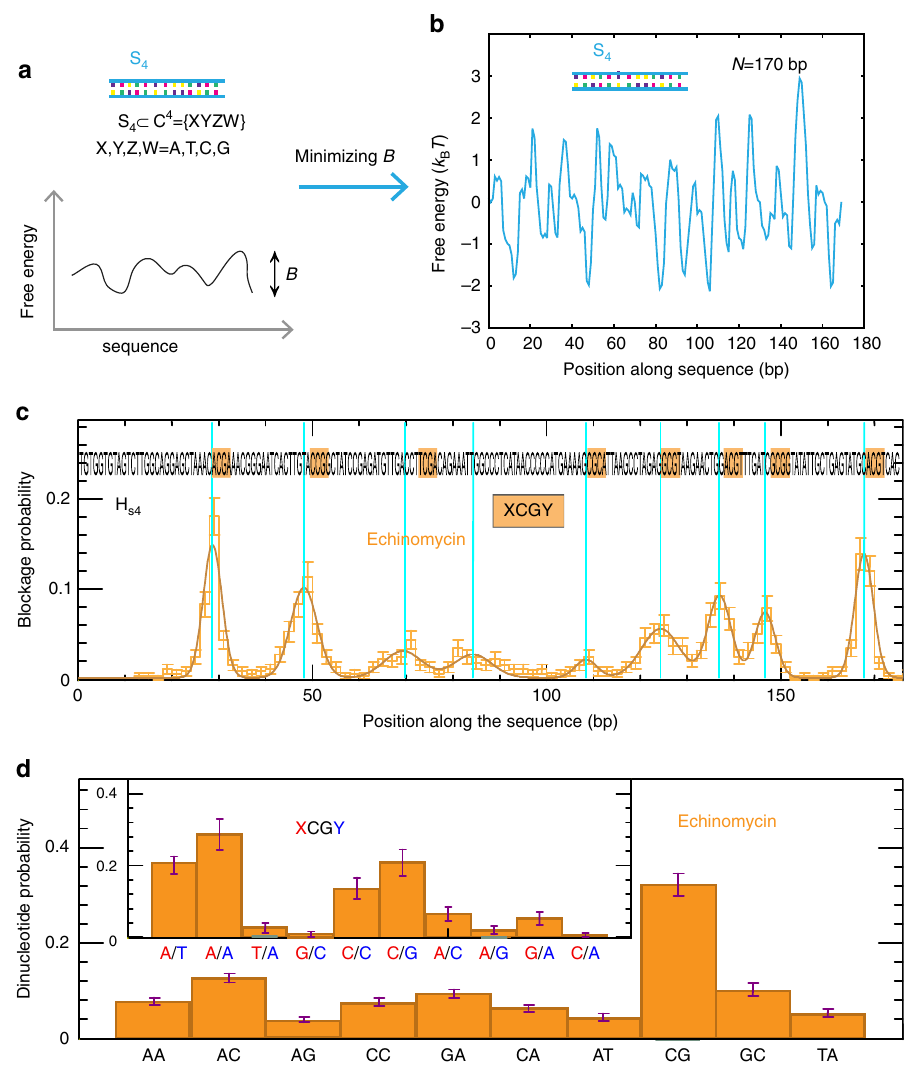
Fig. 4 Selectivity measurements in optimized DNA sequences. a Schematics of the design of an optimized sequence S 4 for selectivity measurements of ligands that bind or recognize 4 bps or less. S 4 includes all tetranucleotide combinations ( K = 4). b Free energy landscape of S 4 sequence, containing 170 bps, obtained by Monte Carlo minimization of the roughness of the unzipping free energy landscape (Methods section). c Distribution of blockage positions obtained applying the FC protocol with hairpin H s 4 in presence of Echinomycin (number of beads = 182). Error bars are inversely proportional to the square root of the number of points for each bin. d The probability of observing a blockage at each possible dinucleotide step obtained from the results presented in c . The inset shows the probability of observing a blocking event at XCGY positions with X, Y = A,T,C,G. Error bars are inversely proportional to the square root of the number of points for each